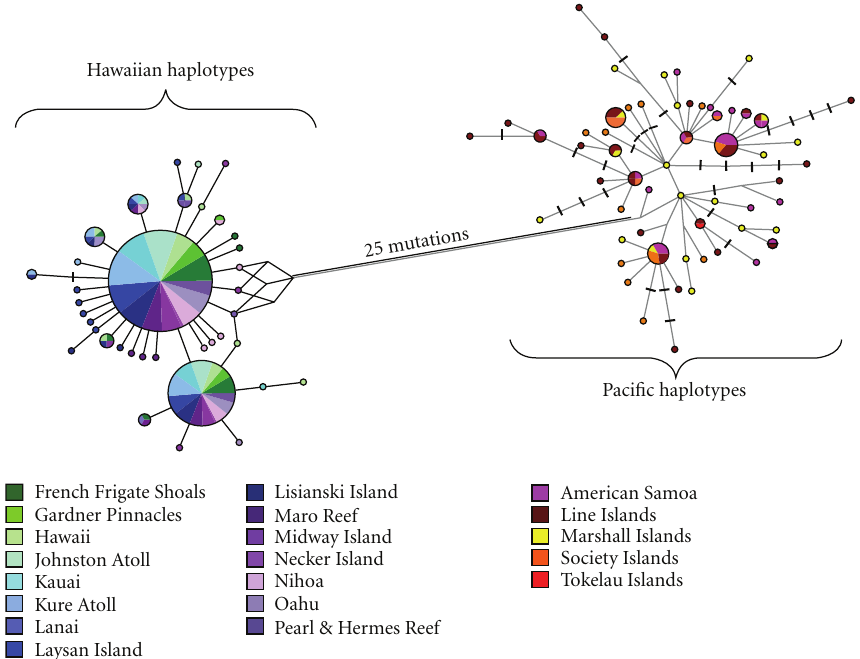
Figure 2: Median-joining statistical parsimony network based on 797 bp of mitochondrial cyt b sequence data ( N = 544) from Acanthurus nigroris sampled across the Pacific. Each circle represents a haplotype, and its size is proportional to its total frequency. Branches represent a single nucleotide change and black crossbars indicate unsampled haplotypes; colors denote collection location as indicated by the embedded key. It should be noted that there were no shared haplotypes between Hawaiian (including Johnston Atoll) and the remaining Pacific populations, which form two distinct clades separated by 25 mutational steps (corrected sequence divergence, d = 4 . 12%;